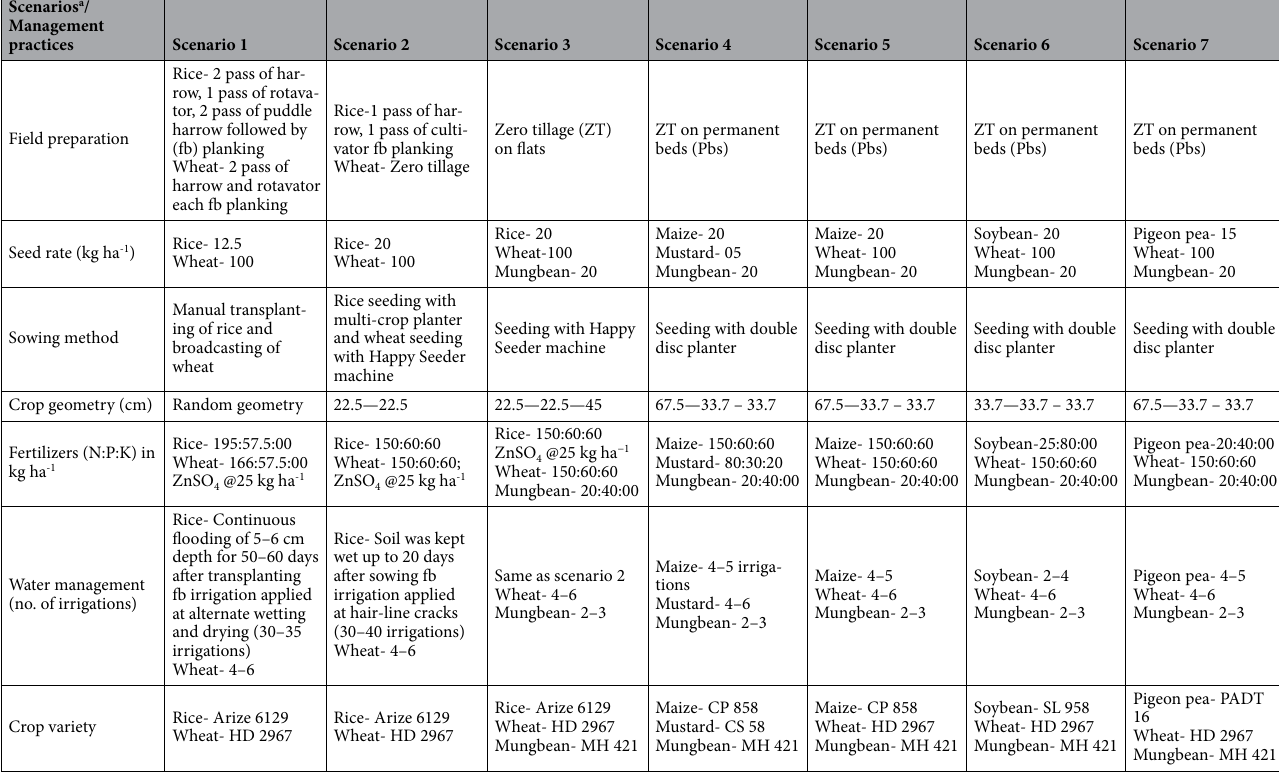
Table 5. Crop management practices for crops and cropping systems under different management